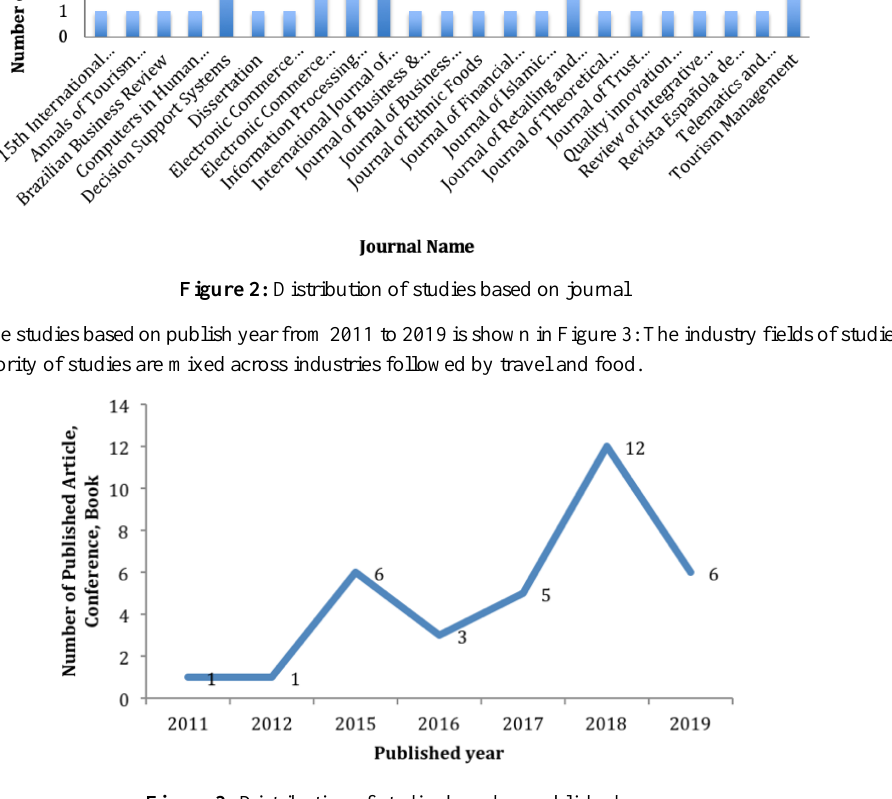
Figure 3: Distribution of studies based on published